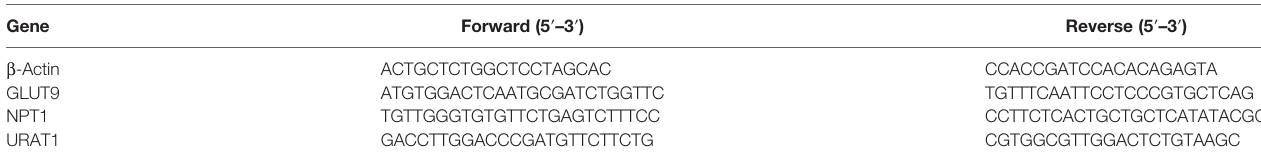
TABLE 1 | Target gene primer